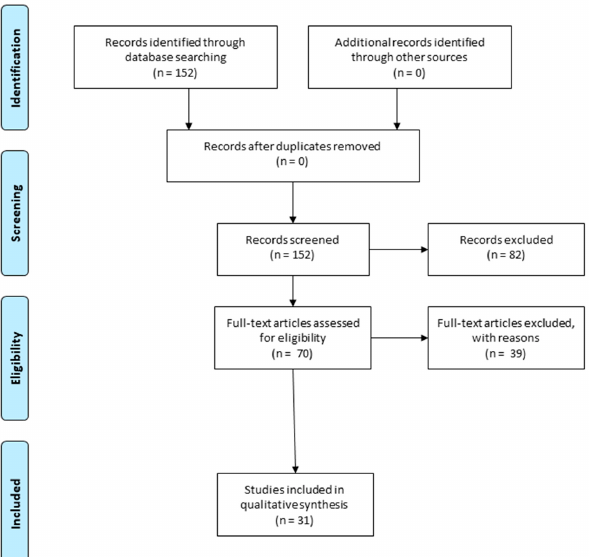
Figure 1. Prisma flow diagram details the methodology that was applied to choose the preclinical studies that were used for the writing of the review. Duplicate articles were excluded from the total number of studies that were recorded. Instead, we selected the articles that describe the role of natural compounds in the activation of Nuclear Factor Erythroid-2 Related Factor 2 (Nrf-2) signaling, which is important to promote injury repair and restore functional deficits (The PRISMA Statement is published in [23] ).